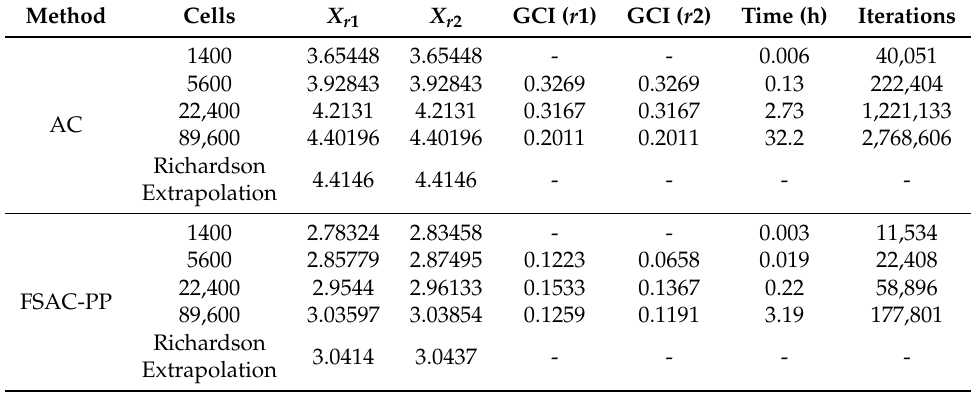
Figure 2. Geometry of the channel with a sudden expansion. Boundary conditions are given for the inflow, outflow and solid (wall) boundary condition. Table 1. Grid dependency study for the AC and FSAC-PP method at a Reynolds number of Re = 30. The expected value of the reattachment length is X r 1 , X r 2 = 3.080 as given by Oliveira [38].